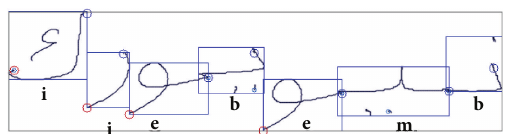
Figure5:OutgoingfromtheUnicodesequence( the forms ( i solated, e nd, m iddle, and b egin) of all letters are (cid:4) # H (cid:22)(cid:24)(cid:8) H (cid:22)(cid:23)(cid:8)(cid:18) (cid:22) determined ( (cid:24) (New